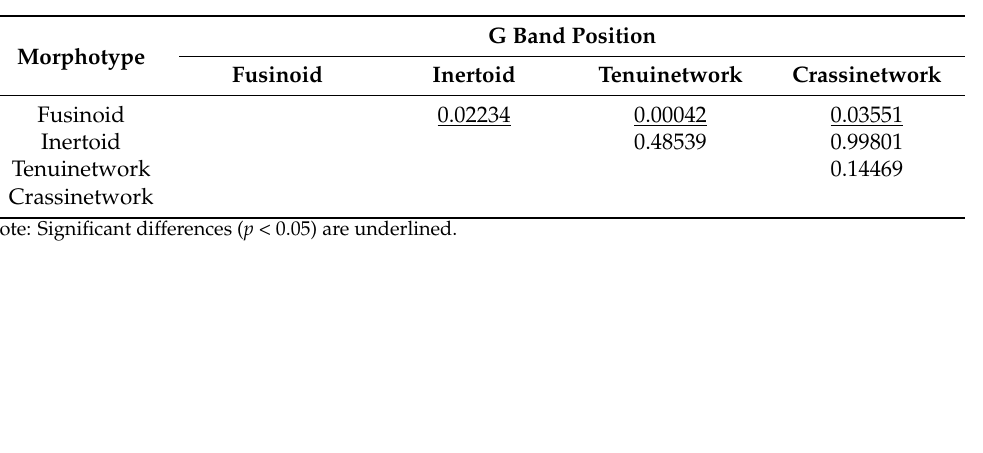
Table 8. Results of the Tukey’s HSD multiple comparison test for the G band